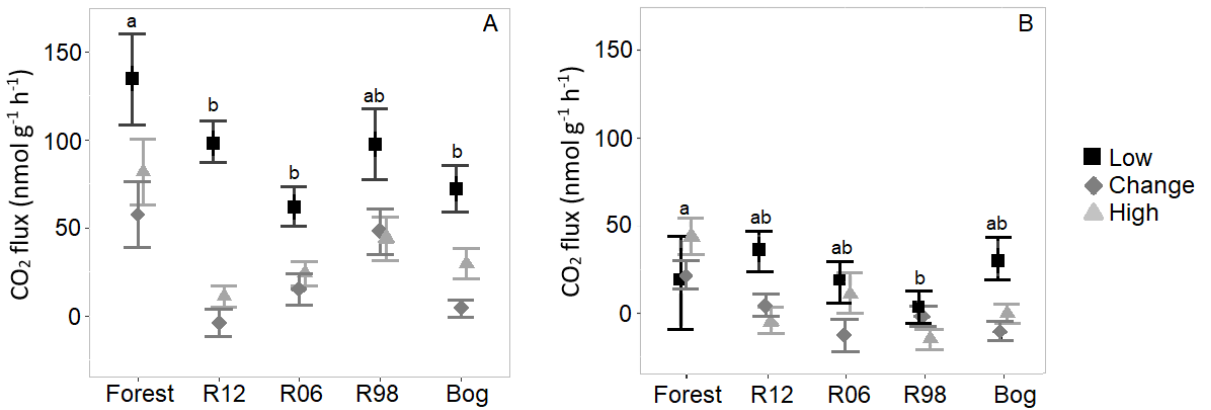
Figure 2. Carbon dioxide (CO ) fluxes per core depth, points are averages over all measurement rounds 2 (n=5). Error bars are standard errors. A) Shallow cores, B) Deep